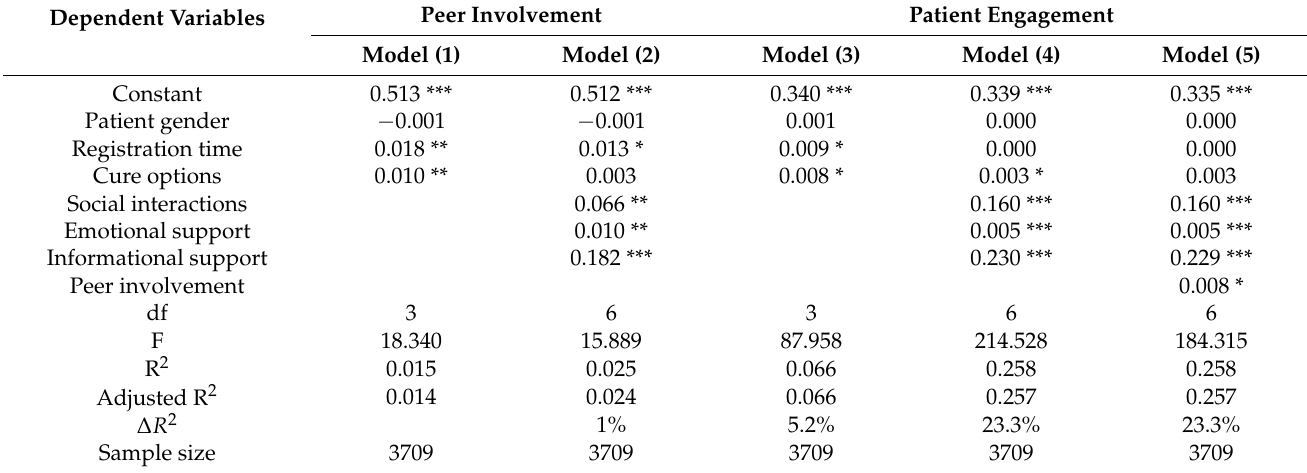
Table 3. Results of the main